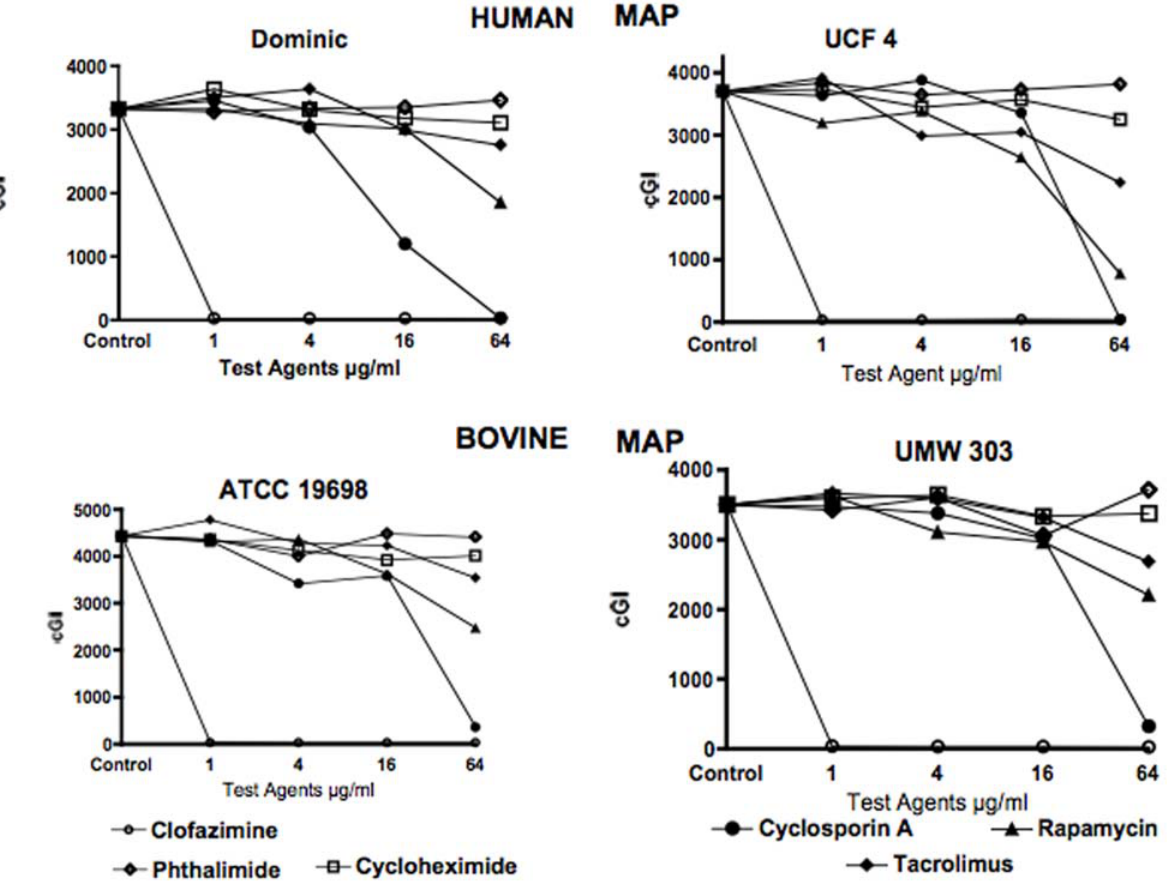
Figure 2. Shown is a composite of four MAP strains. The upper two are MAP isolated from humans, the lower two, MAP isolated from ruminants. ‘‘UMW 303’’ is University of Madison Wisconsin. UCF -4 is University of Central Florida. Note how cyclosporine is consistently the most effective of the three ‘‘immunosuppressants’’ tested (see also Table 5) followed by Rapamycin. The least effective of the three macrolides is Tacrolimus. cGI=cumulative Growth Index (Bactec H ) For Dominic the GI was 331 at the time of passage.